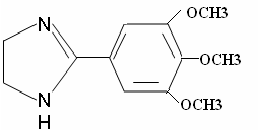
Figure 1. Structure of 3,4,5-trimethoxyphenyl-2-imidazoline